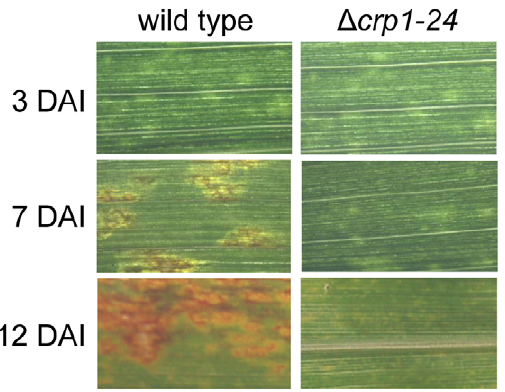
Figure 7. CRP1 regulates conidiation. A, Conidia (10 5 ) of wild type and D crp1-24 were inoculated on V8-agar medium, and incubated for four days in constant white, blue, red light, or darkness. B, Conidia produced by the wild type and CRP1 mutants grown on 0.2 6 PDA in constant white light for seven days.